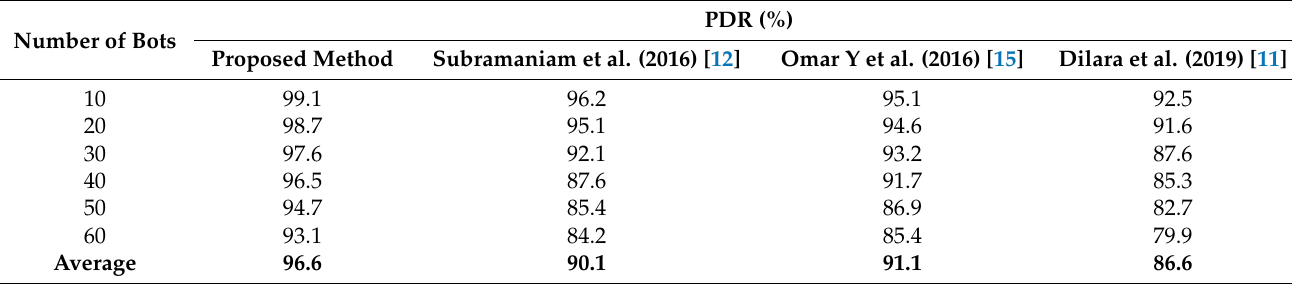
Table 5. Comparisons of PDR using CANFES